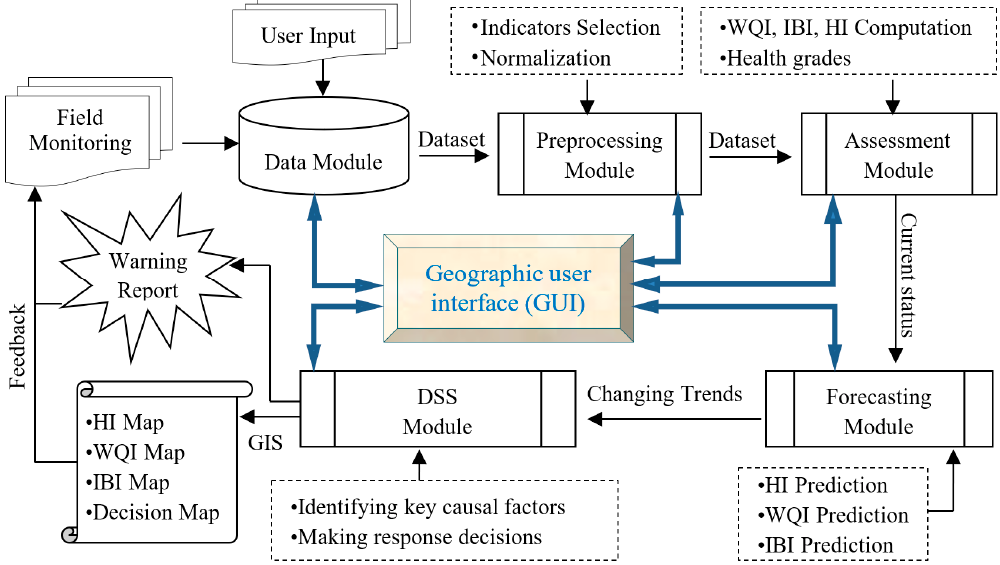
Figure 3. Structure of the river health prediction and early warning system (RHP-EWS) integrated with the three-phase approach.